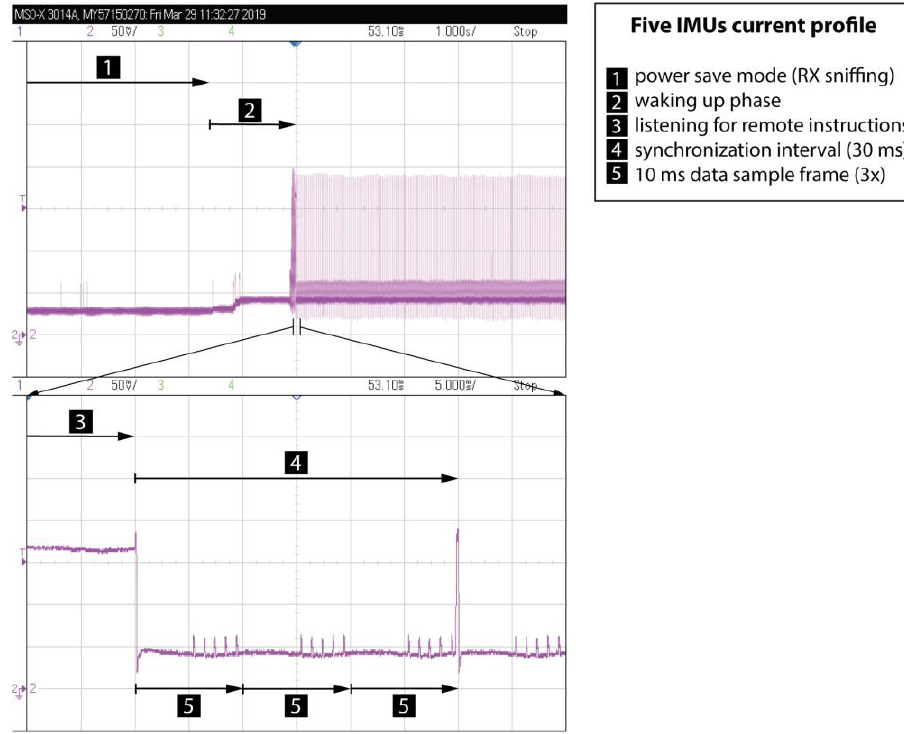
Figure 5. Current draw of five IMU devices, see text for detailed technical description.